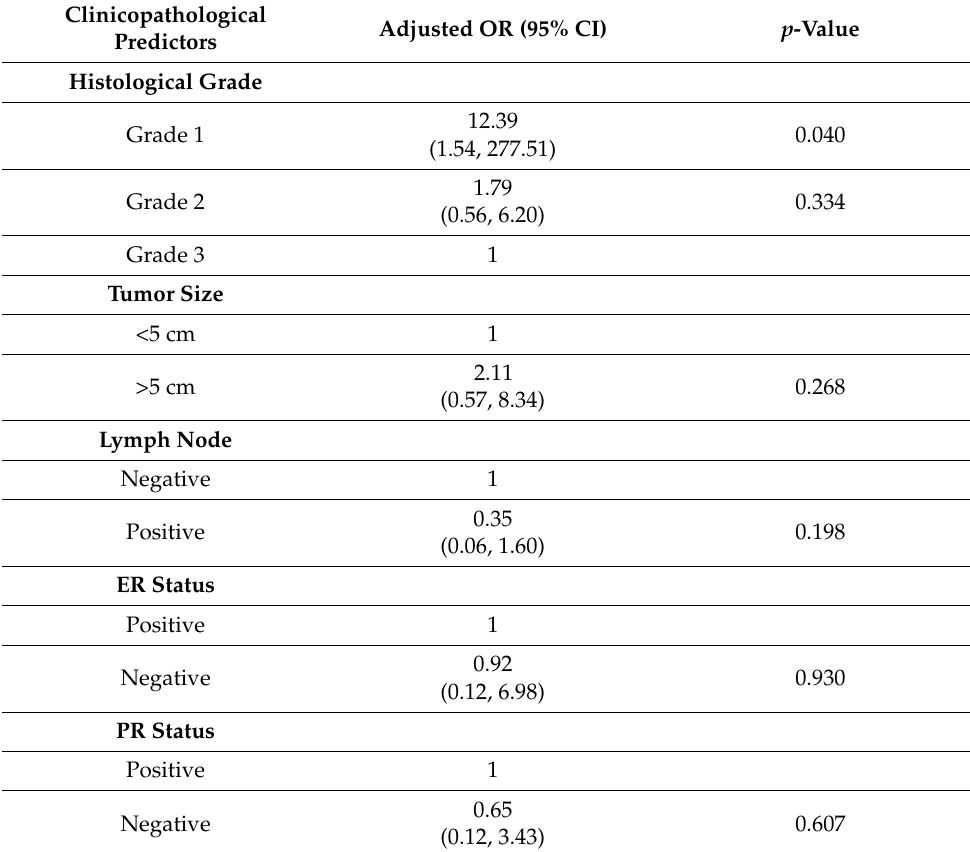
Table 7. Multiple logistic regression analysis of the clinicopathological predictors of ANGPTL4 expression ( n =